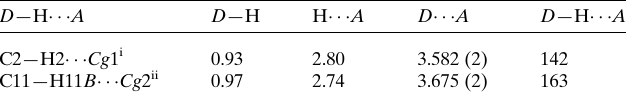
Table 1 C—H (cid:3)(cid:3)(cid:3) (cid:2) interactions (A˚ , (cid:2) ). Cg 1 and Cg 2 are the centroids of the C6–C9/C16/C17 and C1–C4/C18/C19 rings, respectively. D —H (cid:3)(cid:3)(cid:3) A